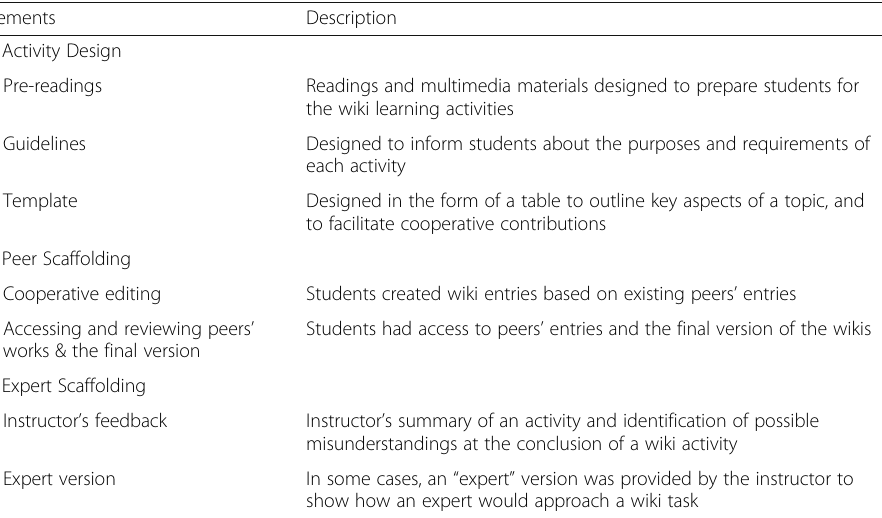
Table 1 Scaffolding Strategies to Support Wiki Learning